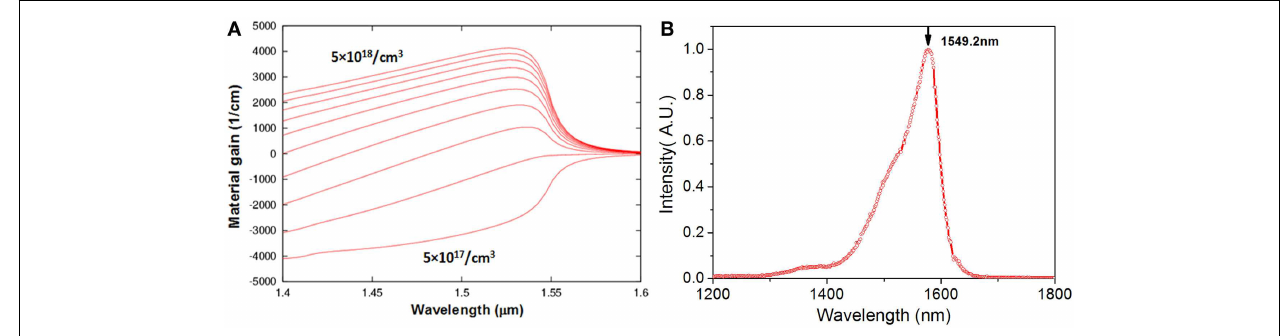
FIGURE 6 | (A) The calculated gain spectrum under different carrier injection concentration. (B) The measured photoluminescence (PL) spectrum for III/V epitaxial wafer.